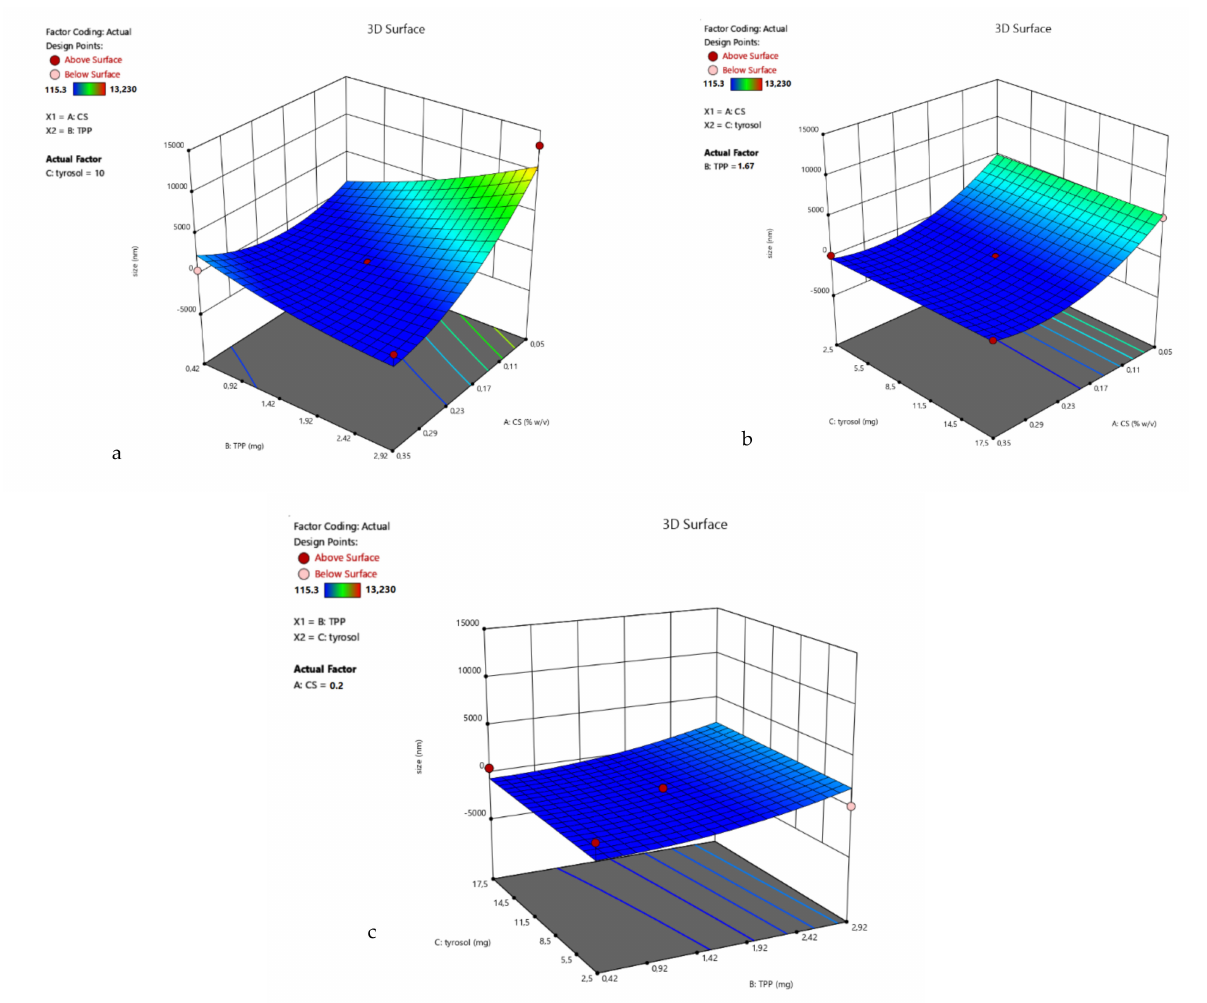
Figure 2. 3D surface plot of response R1 of TYR/CS system ( a ) CS Vs TPP (tyrosol: 10 mg) ( b ) CS Vs TYR (TPP: 1.67 mg) ( c ) TPP Vs TYR (CS: